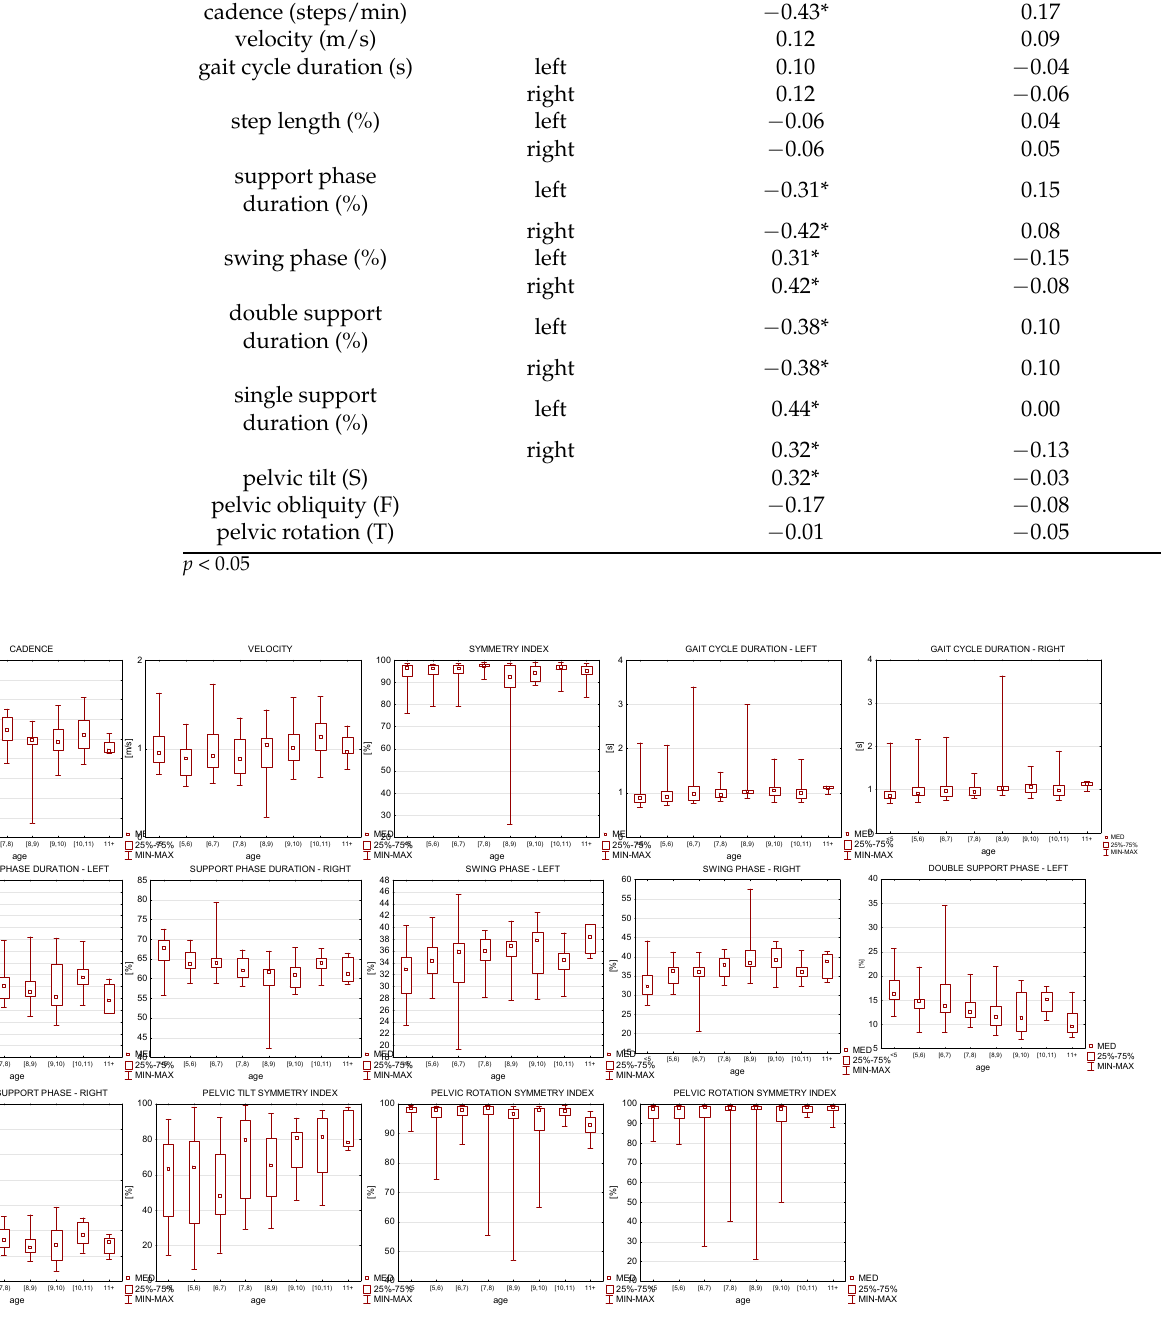
Figure 3. Normative reference gait parameters. Spatiotemporal gait metrics in children. All data reported as median, minimum and